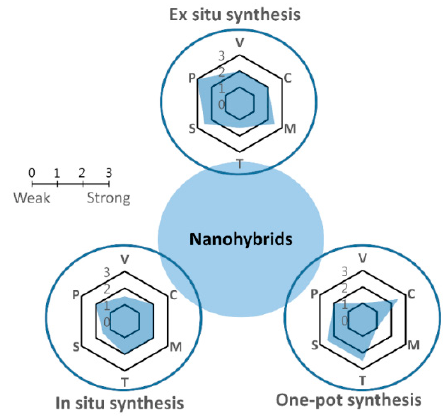
Figure 5. Schematic of nanohybrid synthesis methods. Each mechanism has been evaluated in terms of variables (V), in which a low value means there are many key variables in the synthesis process; cost (C), in which a low value corresponds to high cost; morphology control (M); time required (T); scalability (S); and purity (P) of products.